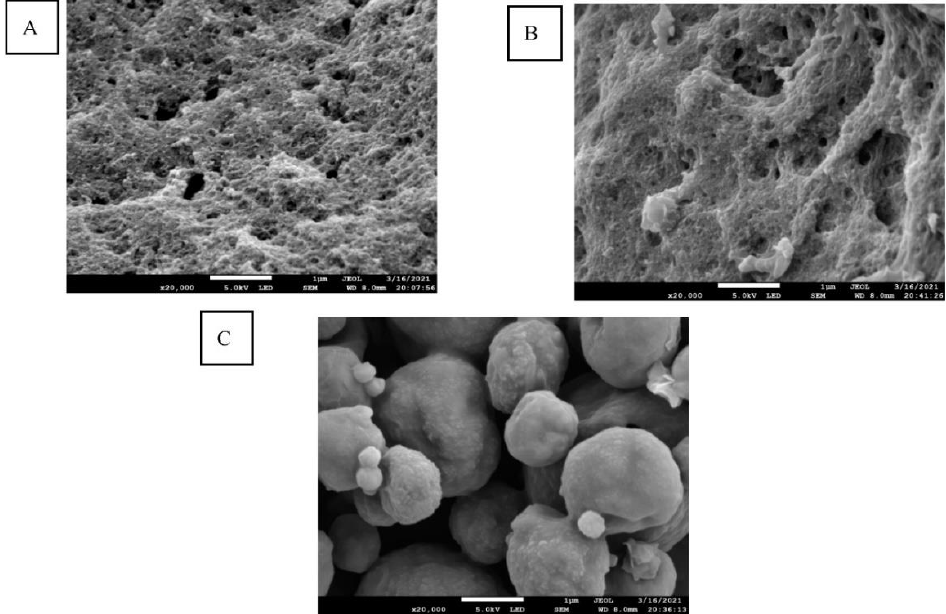
Figure 1. SEM micrographs of UA-loaded chitosan nanoparticles prepared by FD ( A ), MFD ( B ), and SD ( C ). SD ( C